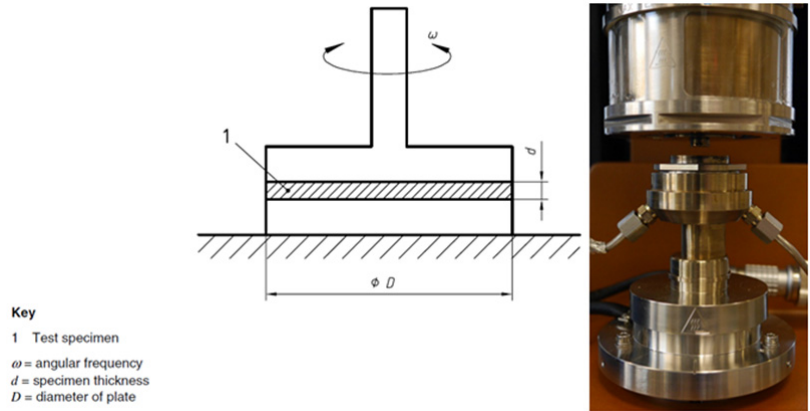
Fig. 2 Measurement in plate/plate geometry: schematically (left) and actual equipment (picture